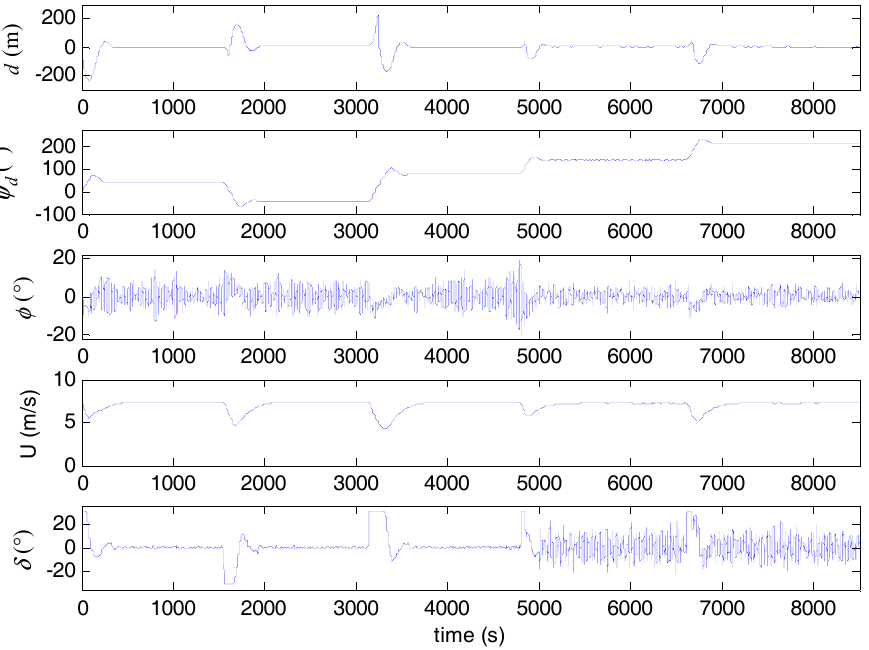
Figure 10. The results of track error, course, roll angle, ship speed and rudder efforts.